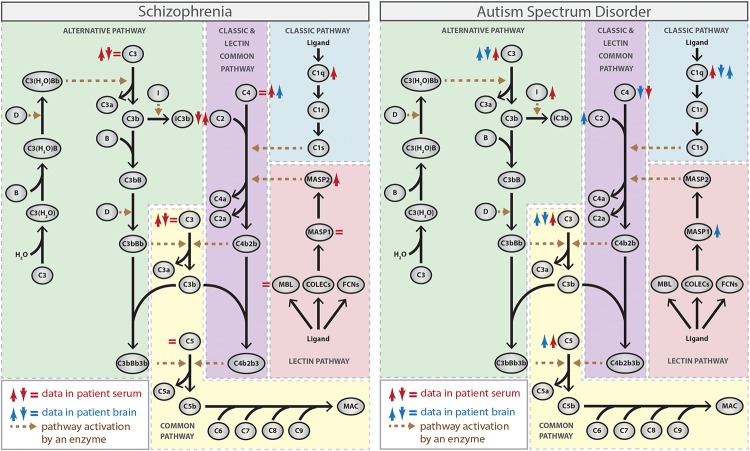
Complement activation pathways and the activity or expression of their individual components (either protein or mRNA) in schizophrenia and autism spectrum disorder (ASD). ↑ red, increased protein activity or expression in blood from patients; ↓ red, decreased protein activity or expression in blood from patients; ↑ blue, increased RNA expression in brain tissues from patients; ↓ blue, decreased RNA expression in brain tissues from patients (Spivak et al., 1989, 1993; Warren et al., 1994; Wong et al., 1996; Maes et al., 1997; Shcherbakova et al., 1999; Hakobyan et al., 2005; Mayilyan et al., 2006; Corbett et al., 2007; Boyajyan et al., 2010; Momeni et al., 2012; Nardone et al., 2014; Li et al., 2016; Sekar et al., 2016; Fagan et al., 2017; Shen et al., 2018). The Figure does not distinguish between strong and weak evidence.